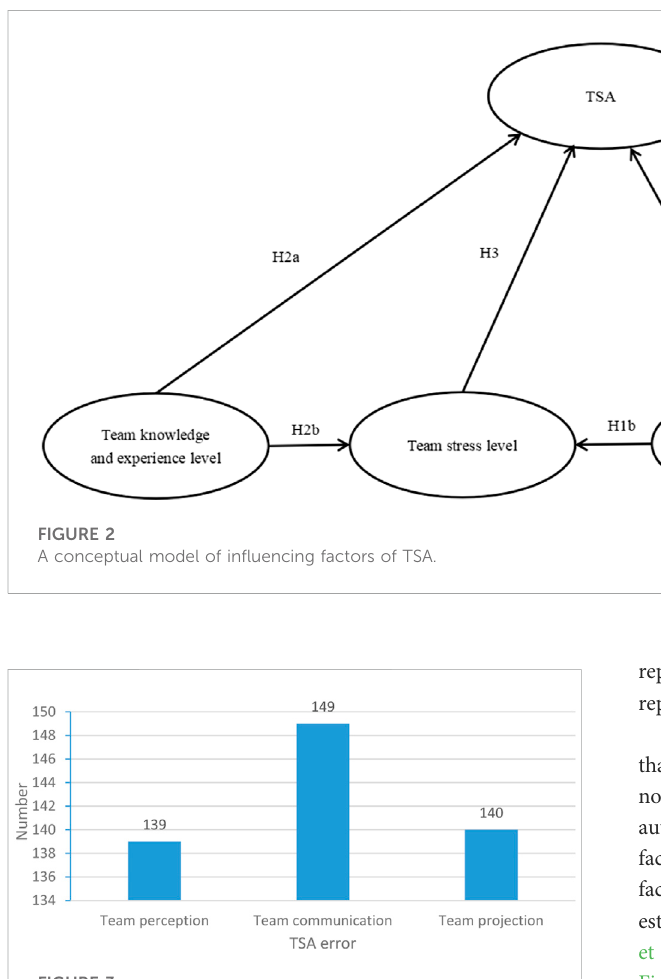
FIGURE 3 TSA error